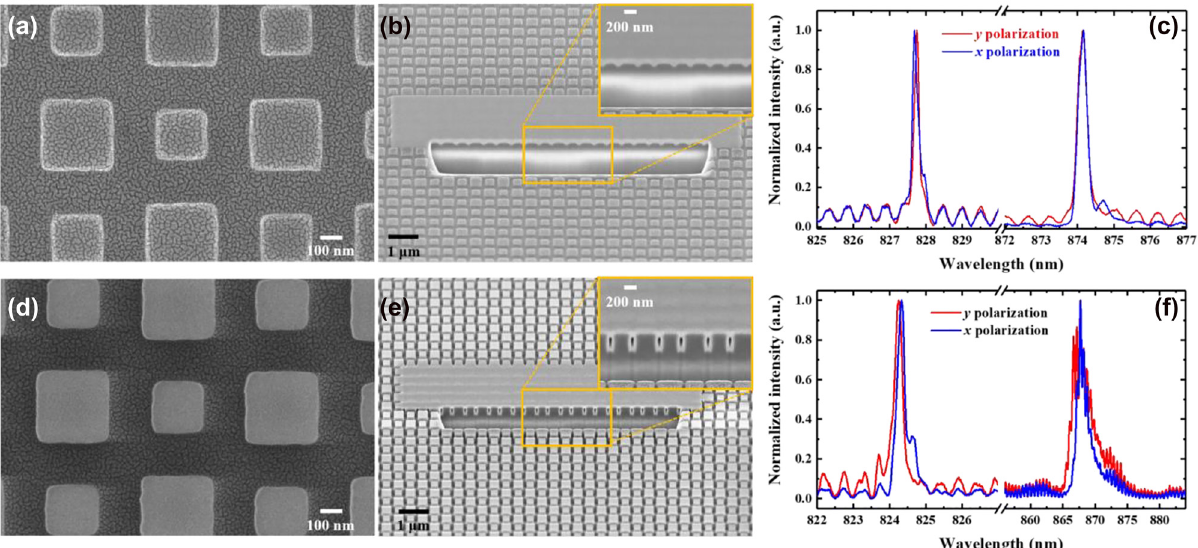
Figure 5: Images and optical properties of ATM structures. (a, d) Top-view SEM images and (b, e) side-view focused ion beam (FIB) cuts of shallow and thick ATM. Inset: FIB cuts in a magnified view. (c, f) Experimental reflection spectrum for shallow and thick ATM in air. The geometric parameters were = ∼ 60 nm and t = ∼ 140 nm for shallow ATM; t = ∼ 300 nm, and t = ∼ 100 nm for thick ATM. The array size is 500 μ m × 500 μ set as follows: t g w g g w g